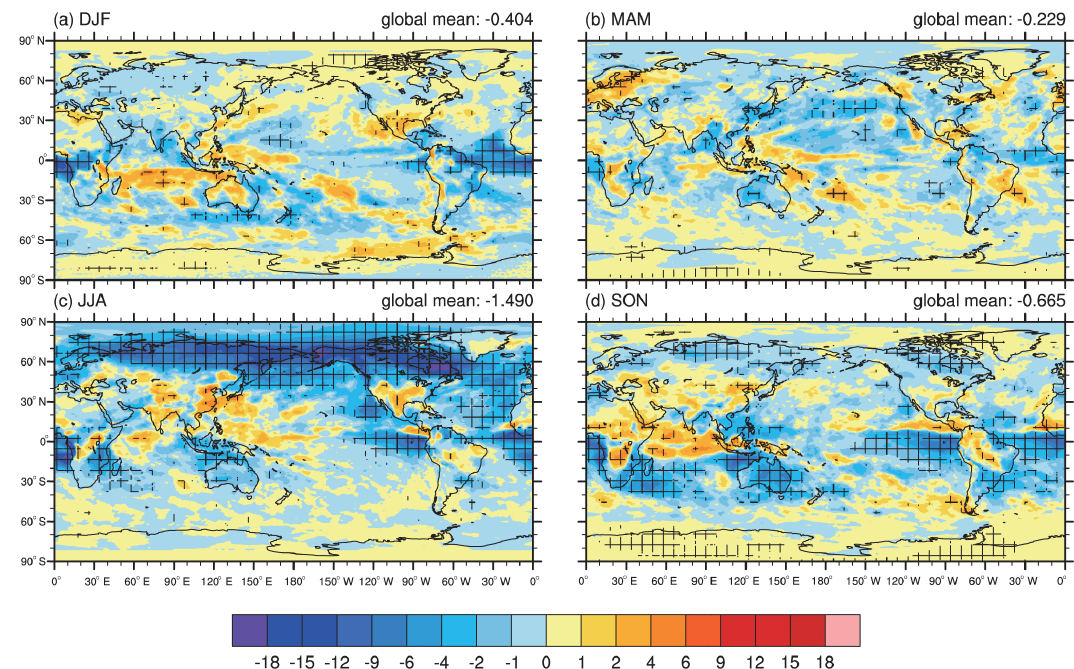
Figure 7. Seasonal variation of radiative effects of all fire aerosols due to aerosol–cloud interactions (REaci) (Wm − 2 ) for the period of 2003–2011 for (a) December–January–February (DJF), (b) March–April–May (MAM), (c) June–July–August (JJA) and (d) September– October–November (SON). The plus signs denote the regions where the radiative effect is statistically significant at the 0.05